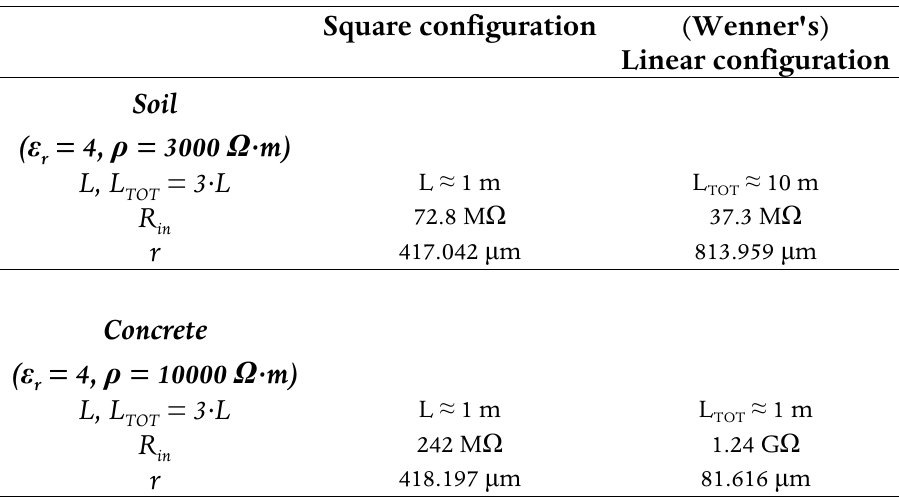
that is connected to an IQ sampling ADC with bit resolution n = 12, to perform in